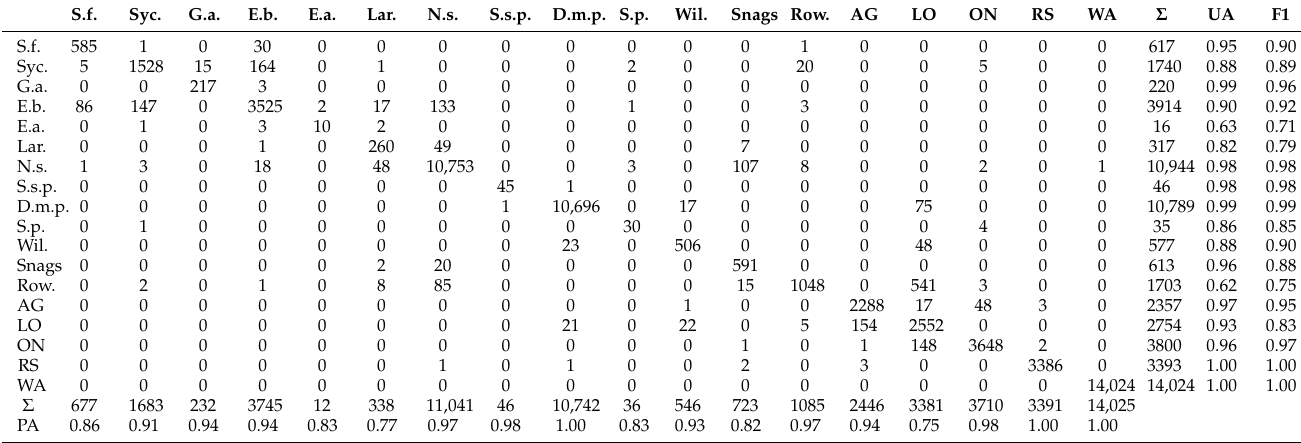
Table A4. Error matrix of obtained HySpex, with topographic features and Random Forest clas- sification results. S.f.—silver fir ( Abies alba ); Syc.—sycamore ( Acer pseudoplatanus ); G.a.—grey alder ( Alnus incana ); E.b.—European beech ( Fagus sylvatica ); E.a.—European ash ( Fraxinus ex- celsior ); Lar.—larch ( Larix spp.); N.s.—Norway spruce ( Picea abies ); S.s.p.—Swiss stone pine ( Pinus cembra ); D.m.p.—dwarf mountain pine ( Pinus mugo ); S.p.—Scots pine ( Pinus sylvestris ); Wil.—willow ( Salix spp.); Row.—rowan ( Sorbus spp.); AG—alpine grasslands; LO—low shrubs; ON—other nonforest; RS—rocks and artificial surfaces; WA—water; UA—user accuracy; F1—F1- score; PA—producer